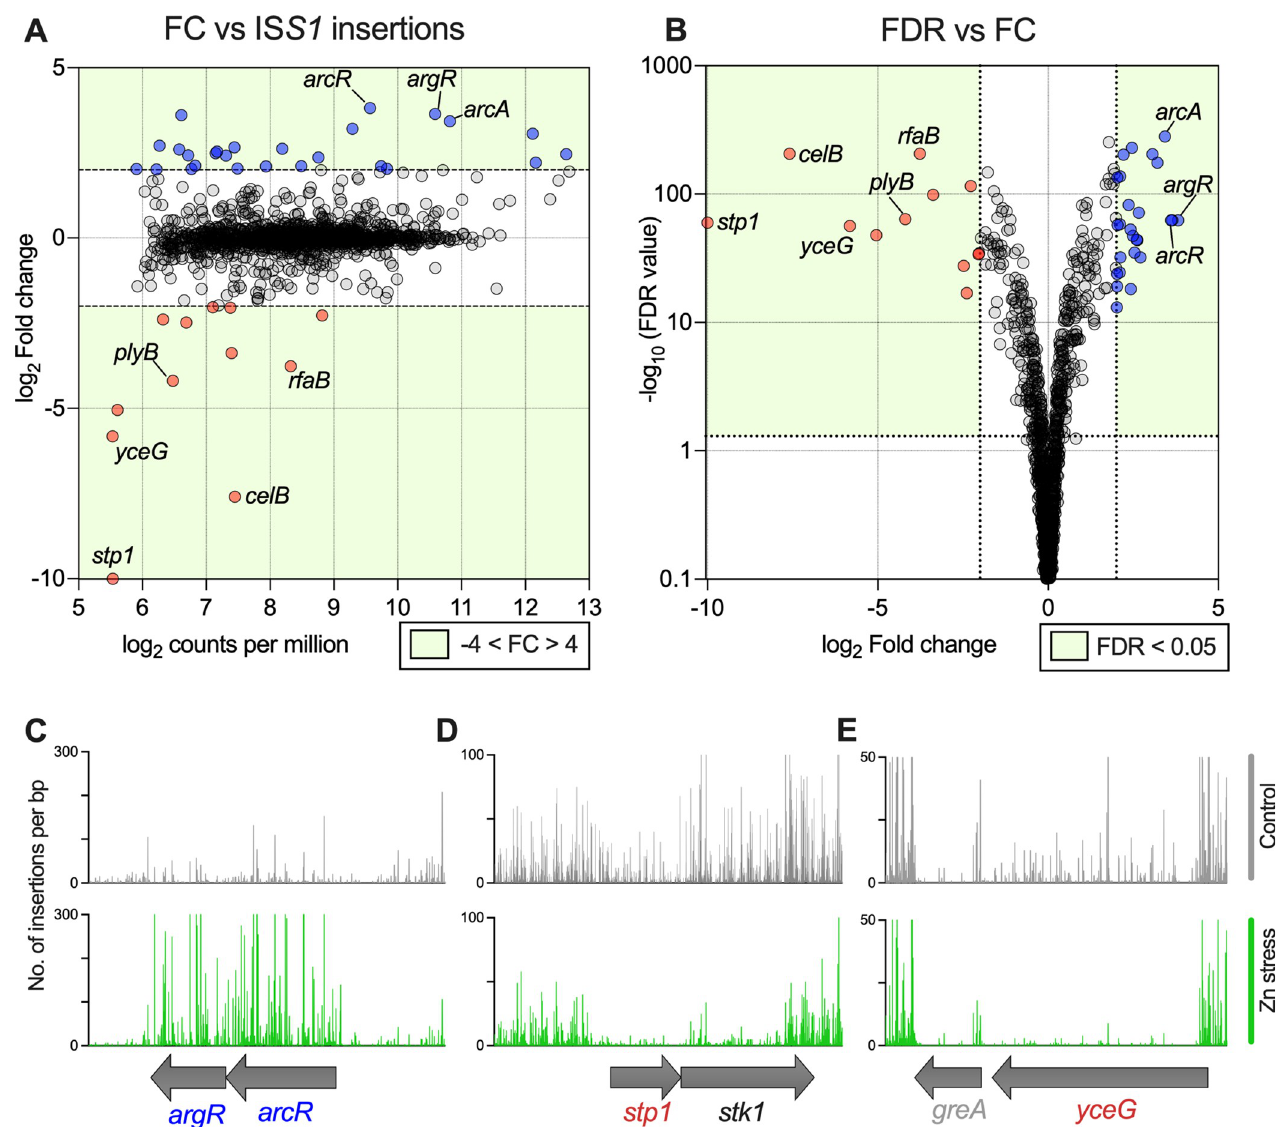
Fig 10. Defining the Zn stress resistome of GBS to identify novel factors in bacterial responses to Zn intoxication. A super-saturated IS S1 GBS insertion library was subjected to Zn stress and compared to control incubation without Zn to define the Zn resistome. Transposon-directed insertion sequencing (TraDIS) identified 26 genes over-represented (blue) and 12 under-represented (red) during Zn stress. Plots showing Fold change (FC) of each gene compared to number of IS S1- insertions per million reads mapped (A) and false discovery rate (FDR; q-value) compared to fold change (B), with green shading indicating genes that satisfied cutoffs as indicated (fold-change ± 4; FDR < 0.05). Illustrative read-mapping of IS S1 insertion sites (C-E) displaying differences between non-exposed control (grey) or Zn stress conditions (green) for selected genes; over-represented argR/arcR (C) and under-represented stp1/stk1 (D) or yceG (E). Vertical lines in C-E represent pooled read counts at each base within each locus, with coding sequences of genes represented by grey arrows beneath. Data are compiled from 3 independent experiments. FDR values (Y) were displayed by -log 10 (Y) transformation followed by plotting on a log 10 y-axis to generate volcano plot